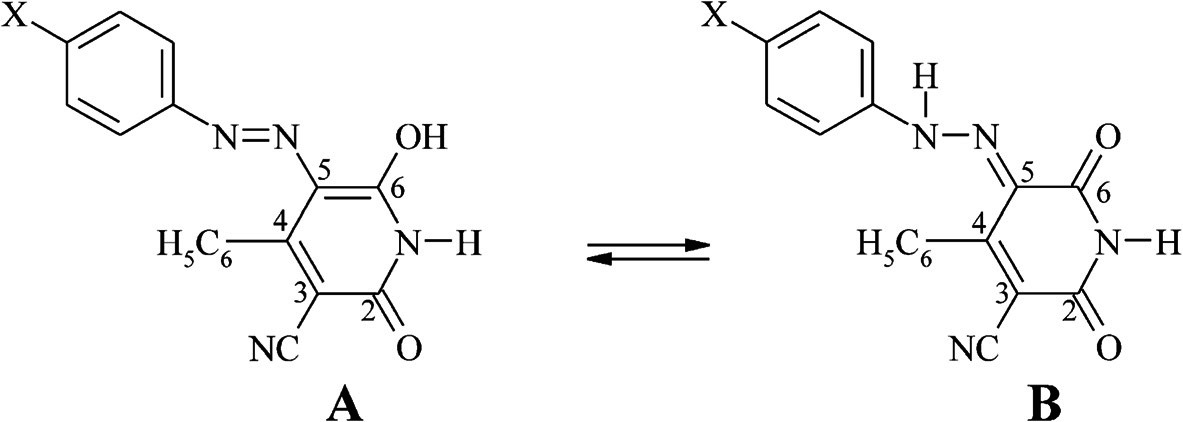
The equilibrium between the azo form (A) and the hydrazone form (B) of 5-arylazo-6-hydroxy-4-phenyl-3-cyano-2-pyridones. (X = H (1), OH (2), OCH3 (3), CH3 (4), Cl (5), Br (6), I (7), F(8), CN (9), COOH (10), COCH3 (11), NO2 (12)).